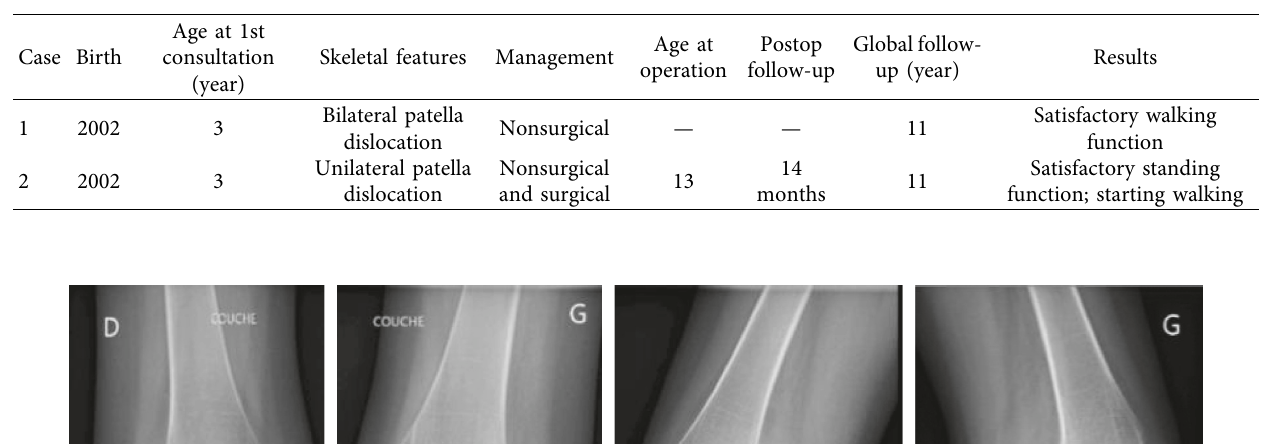
Table 1: Patients’ data.